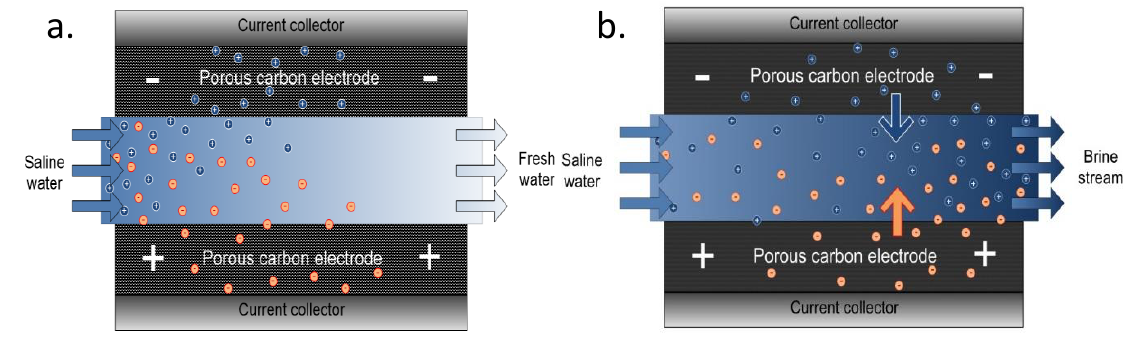
Figure 5. Schematic representation of CDI during ( a ) adsorption and ( b ) desorption process.